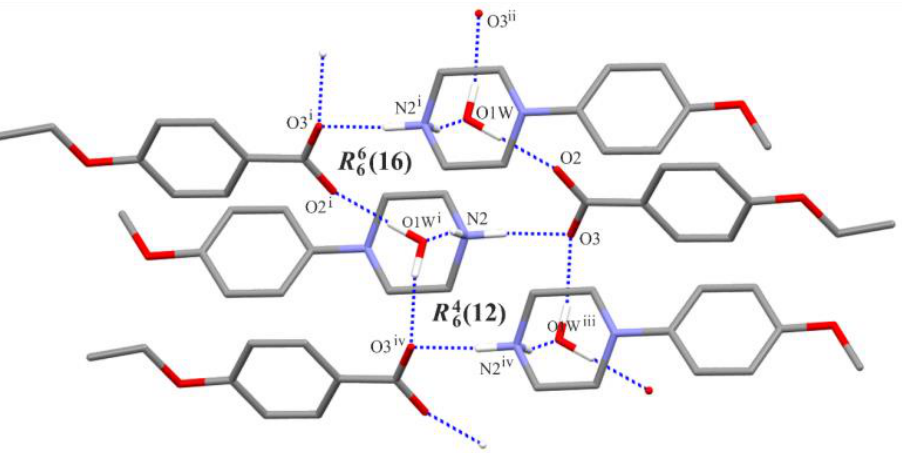
Figure 3. Part of the crystal structure of (I), showing the formation of an infinite chain of rings. For the sake of clarity, (C)—H atoms not involved in the motif shown have been omitted. [Symmetry